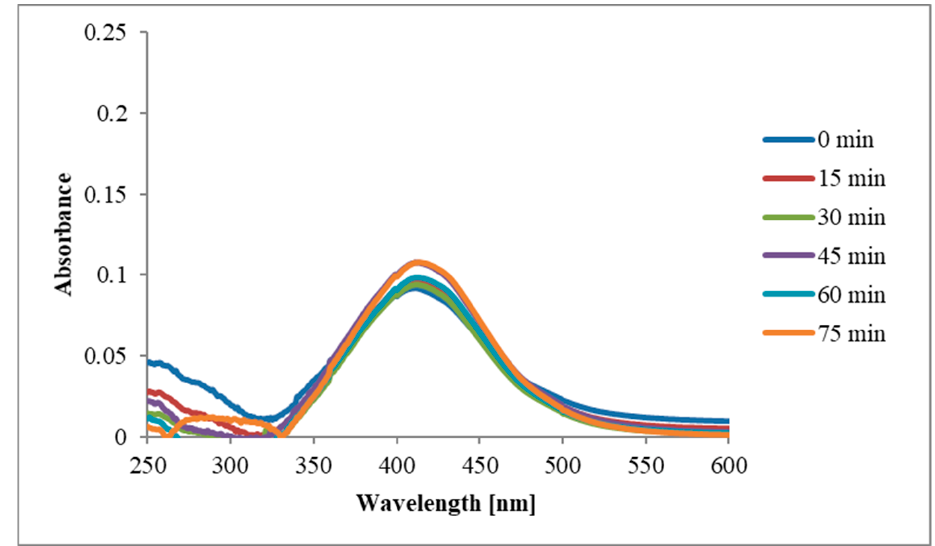
Figure 10. The influence of stirring time (0, 15’, 30’, 45’, 60’, and 75’) on AgNPs-EtOH formation.